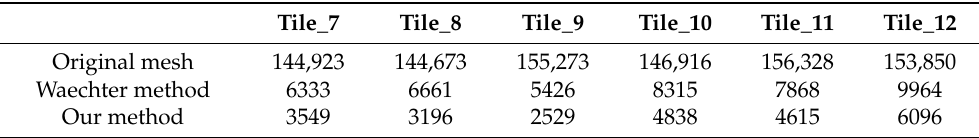
Table 4. Comparison of the number of texture charts using the two methods for texture reconstruction in non ‐ building experimental areas.